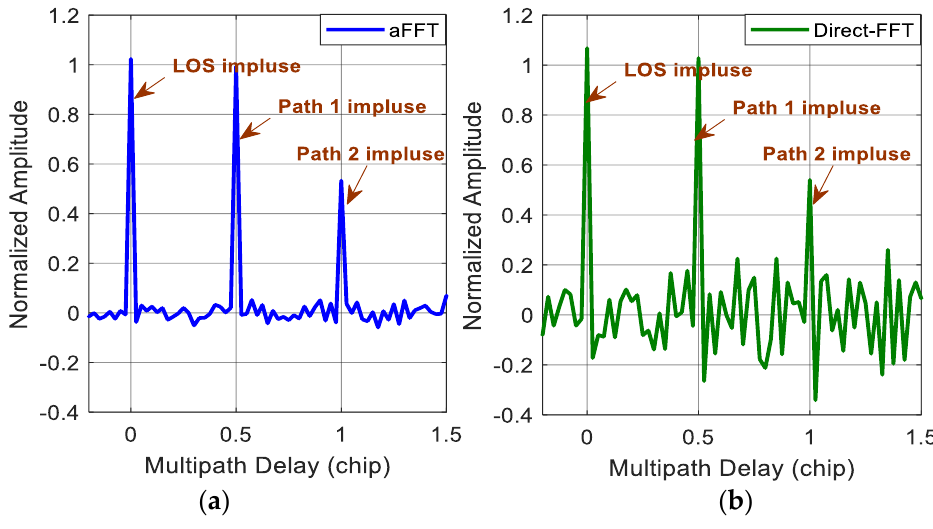
Figure 3. ( a ) Impulse responses of the averaging-FFT method with C/N 0 of 45 dB-Hz; ( b ) impulse responses of the direct-FFT method with C/N 0 of 45 dB-Hz.